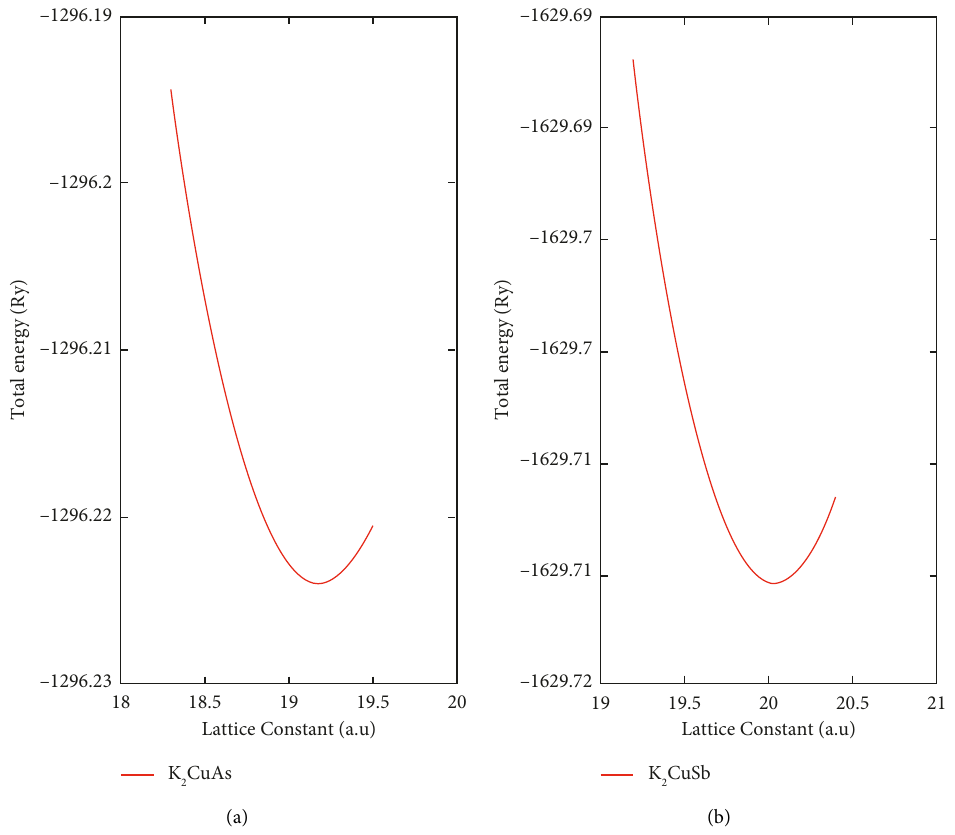
Figure 2: Total energy versus lattice constants computed for (a) K